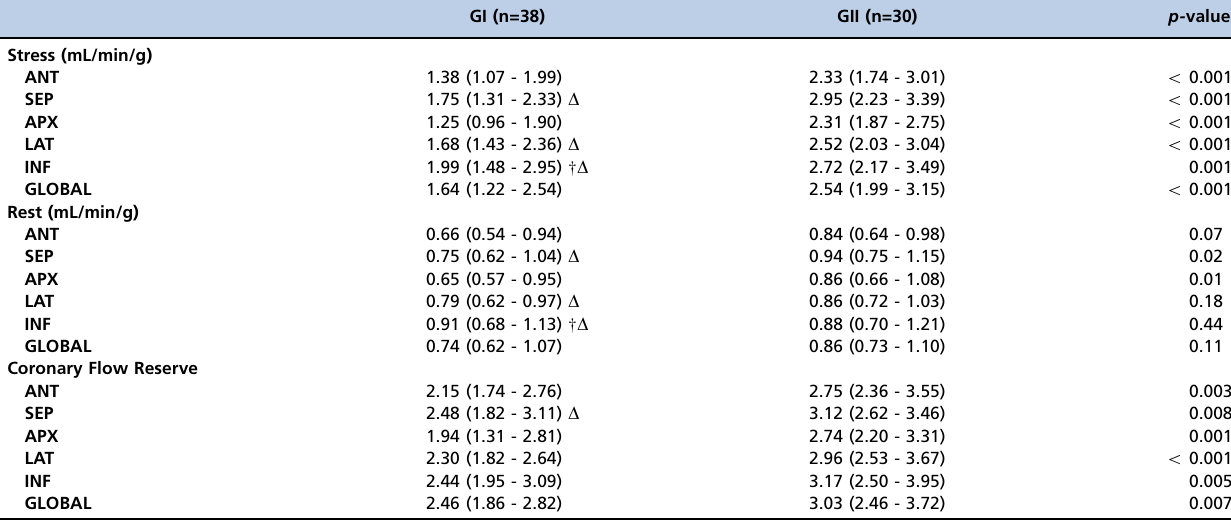
Table 2 - Results of global and regional 82 Rb-PET myocardial blood flow measurements during stress and rest and CFR in GI and GII. GI (n=38) GII (n=30) p- value Stress (mL/min/g) ANT